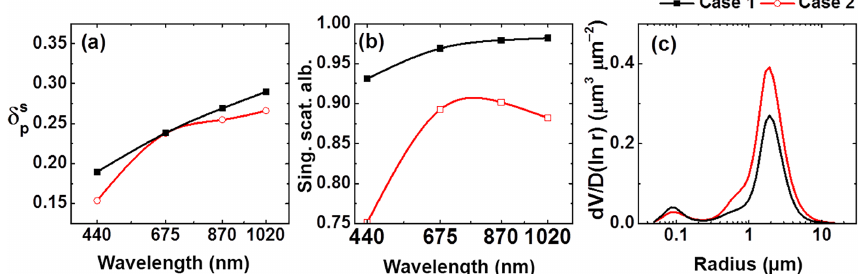
Figure 13. (a) δ S at 440, 675, 870, and 1020nm; (b) SSA at 440, 675, 870, and 1020nm; and (c) volume particle size distributions. Shown P are the results for case 1 (black) and case 2 (red). Cv c / Cv f is inserted in (c) . The observation site is Osaka.